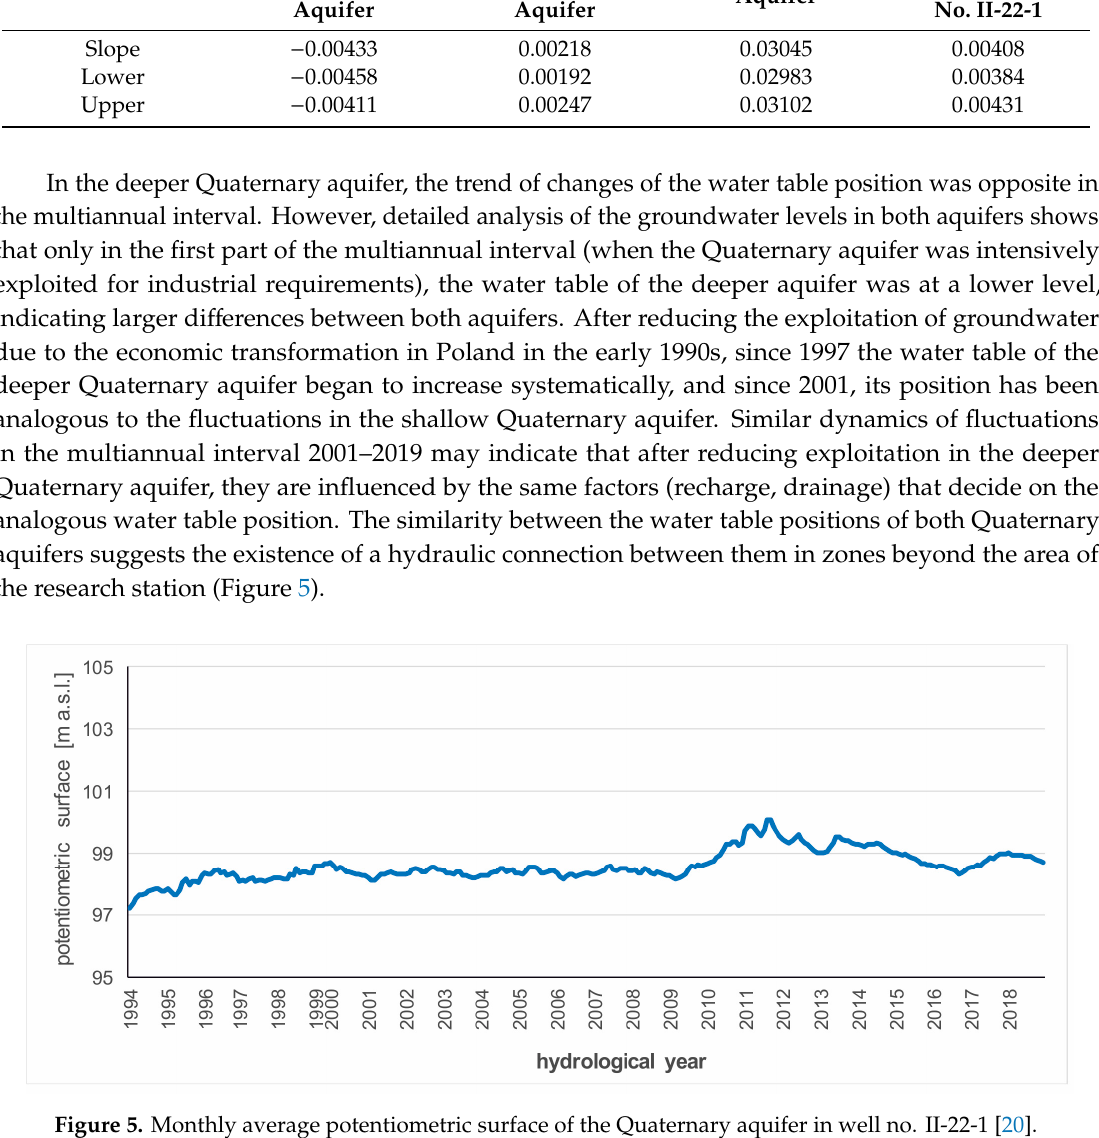
Figure 5. Monthly average potentiometric surface of the Quaternary aquifer in well no. II-22-1 [20].